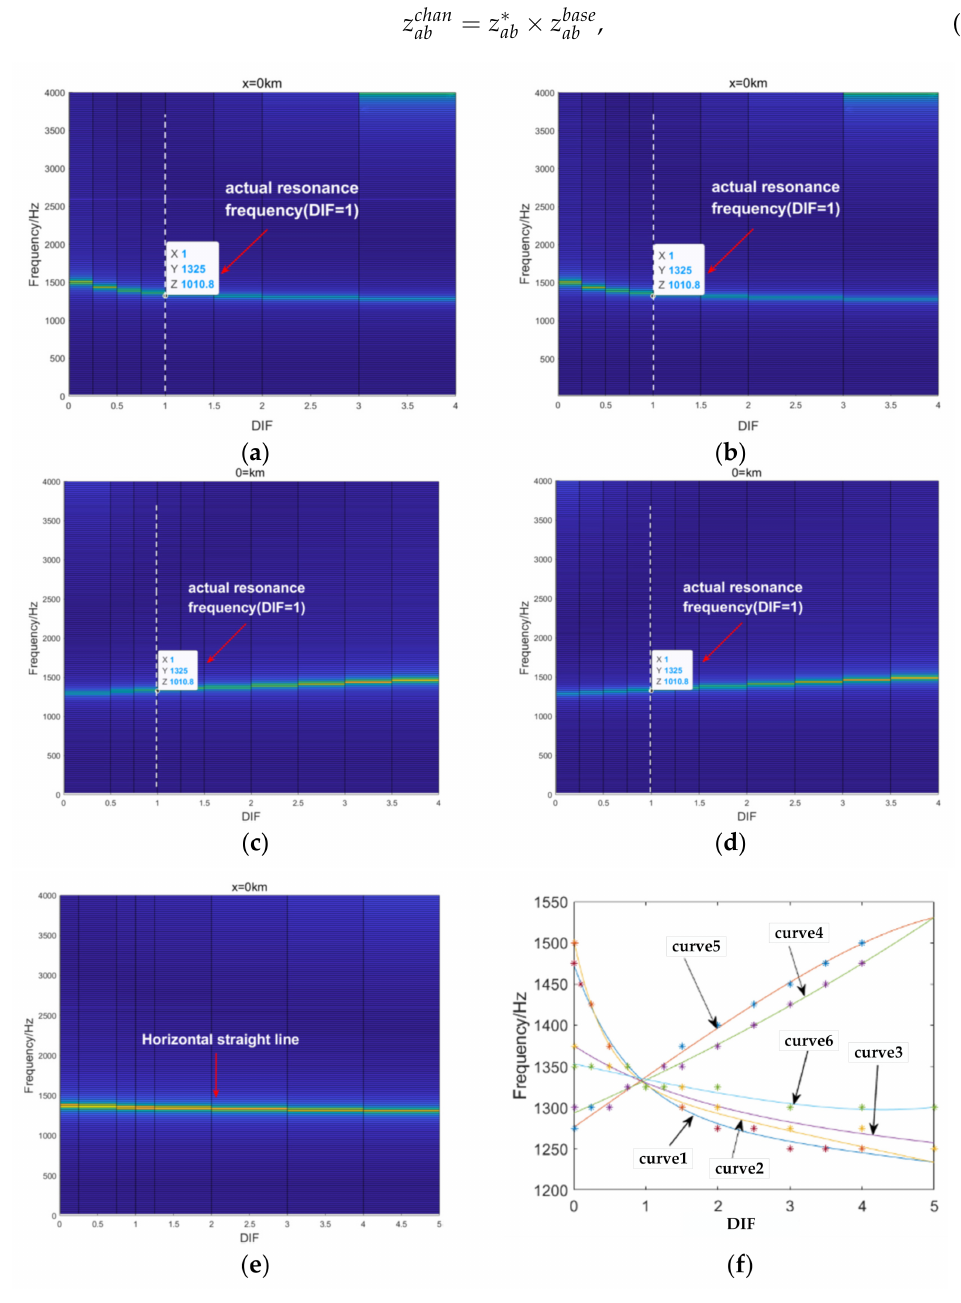
= z ∗ , ( b ) DIF: z ∗ 22 77 = z ∗ ; ( f ) function fitting of 27 72